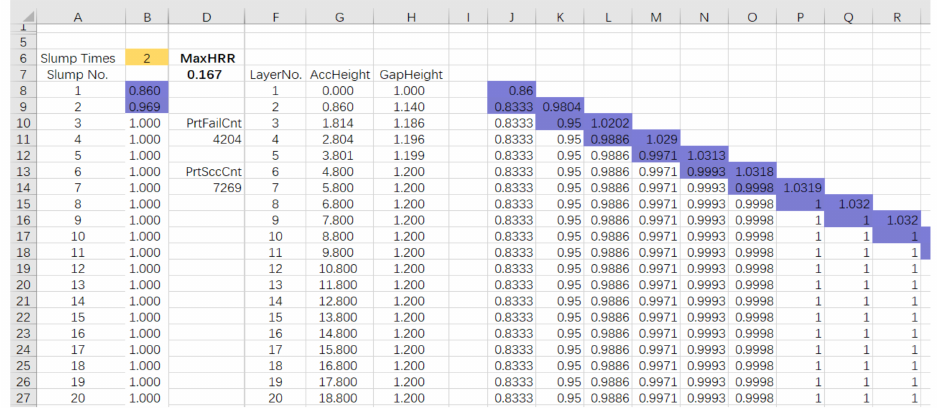
Figure 16. A 2-step slump requirement calculation algorithm of a printing simulation in Excel. Conclusively, based on the “printing” simulation and theoretical calculation, the HRR of PM can be correlated with the printing GHT δ as shown in Equation (9), regardless of the multi-step slump and the compression from self-weight and weight from subsequent layers in a printing